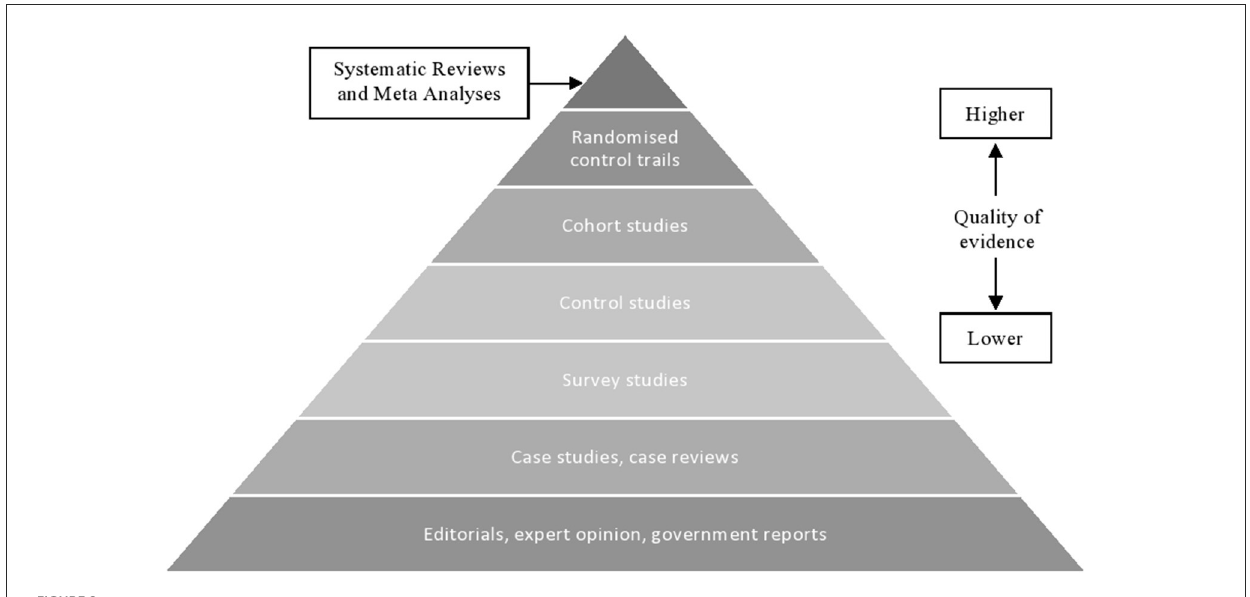
FIGURE2 The evidence of hierarchy pyramid. See, Brighton et al.